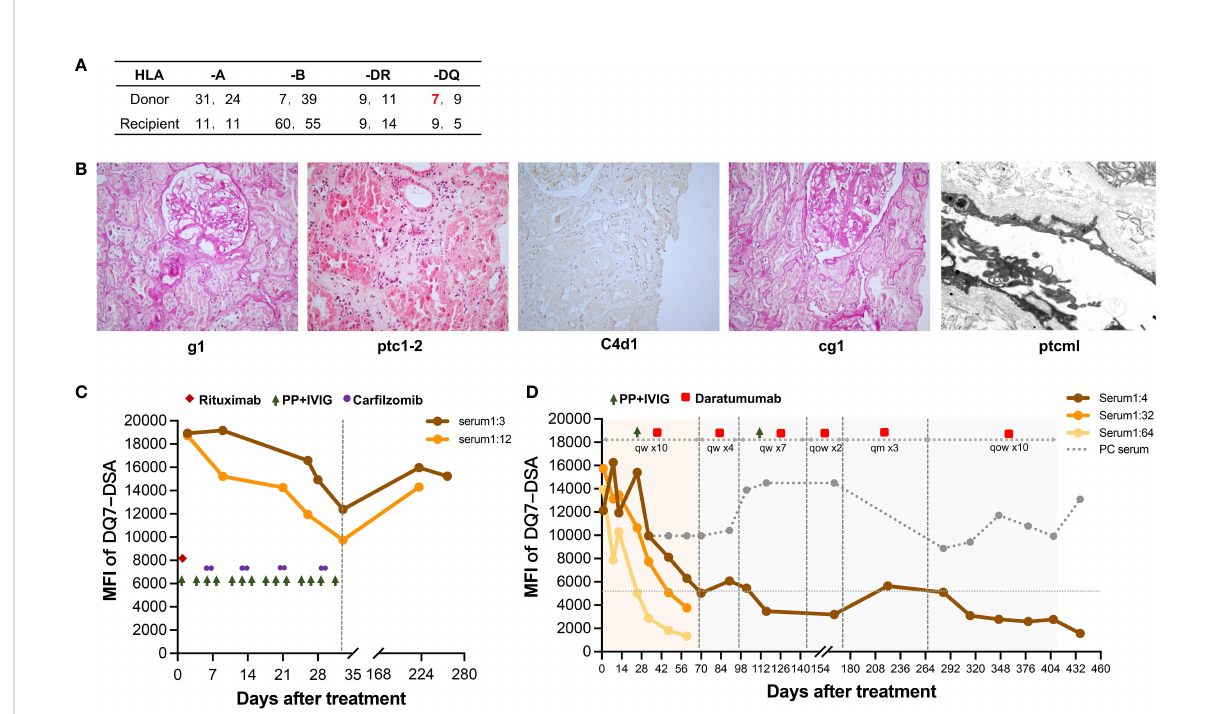
FIGURE 1 Histological features of subclinical chronic active AMR in Patient 1 before treatment and changes in DSA throughout treatment. (A) HLA phenotype results for the recipient and his donor. (B) Typical histological fi ndings of chronic active AMR and their Banff 2017 Scores. (C) Changes in MFI values of the anti-DQ7 DSA (1:3 or 1:12-diluted serum) during the fi rst round of treatment containing rituximab, PP/IVIG, and car fi lzomib. (D) Changes in MFI values of the anti-DQ7 DSA (1:4/1:32/1:64-diluted serum and positive control serum) after the treatment with daratumumab-based